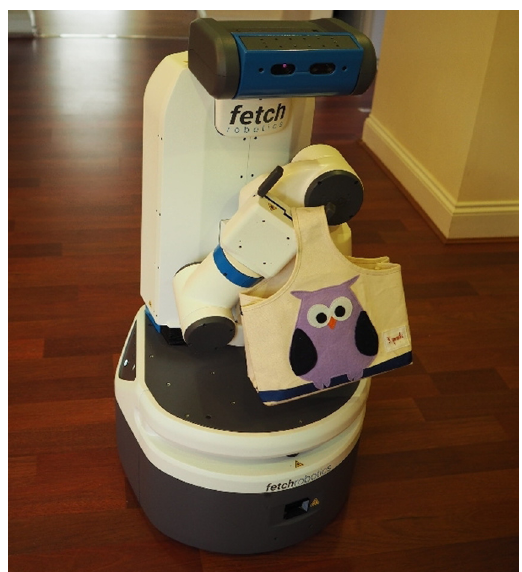
Figure 1: The Fetch robot at Robot House, its arm con fi guration, and the basket used for the